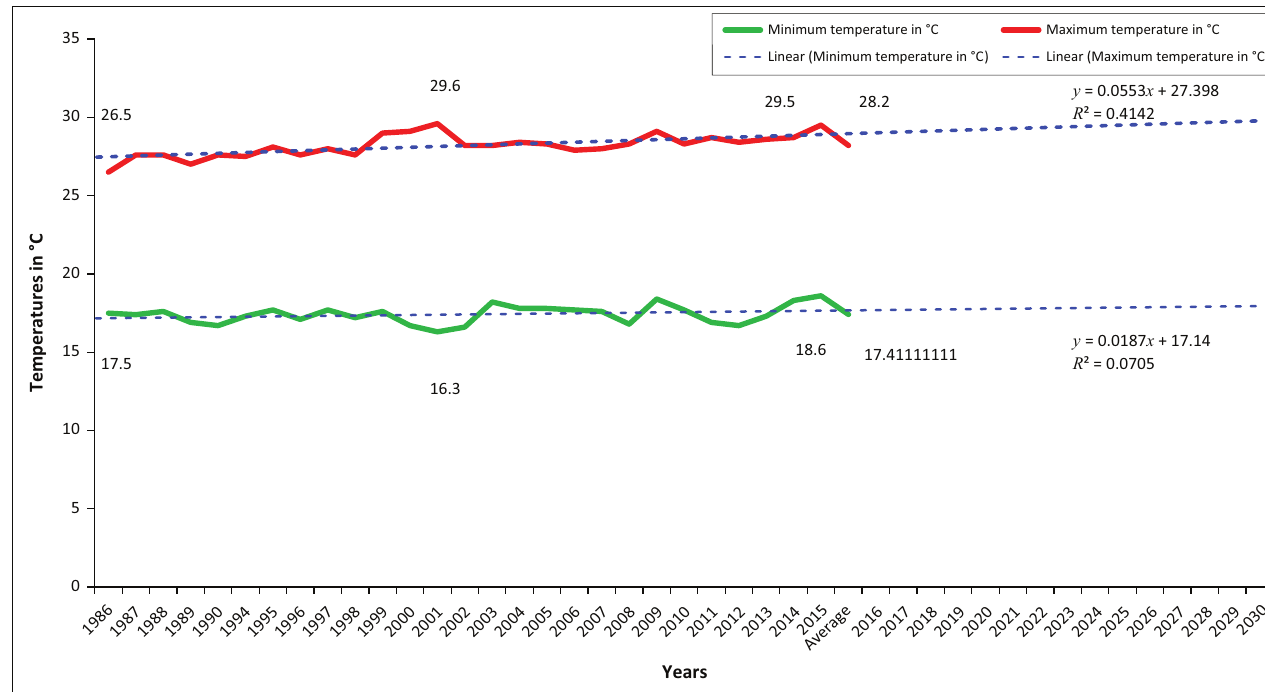
FIGURE 2: Konso mean annual precipitation pattern for period 1986–2015 (in mm) and projection up to 2030.